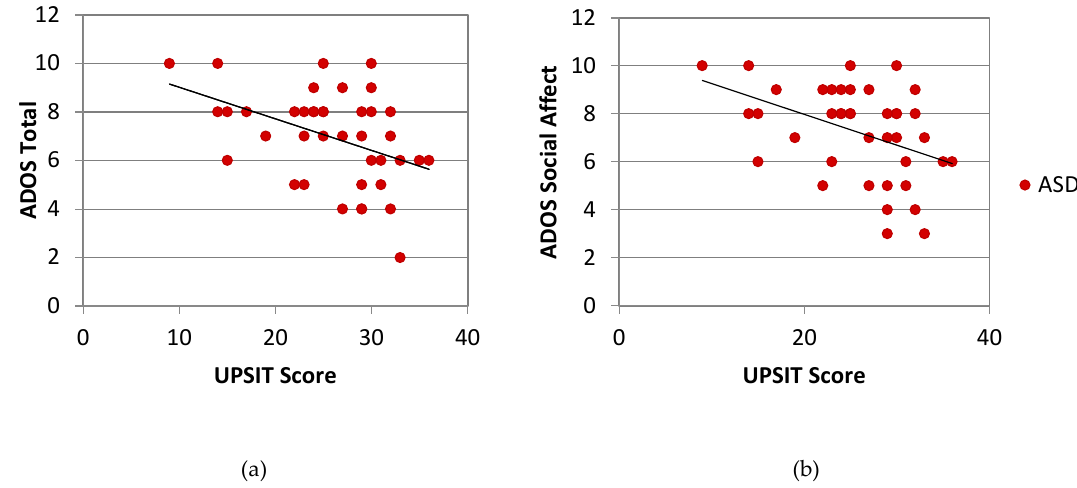
Figure 7. Within groups correlation between smell identification (UPSIT score) and autism severity in the ASD group. Autism severity is displayed separately as ADOS Total calibrated severity score ( a ) and Social A ff ect calibrated severity score ( b ). Each point represents one individual. UPSIT = University of Pennsylvania Smell Identification Test; ADOS = Autism Diagnostic Observation Schedule; ASD = children with Autism Spectrum